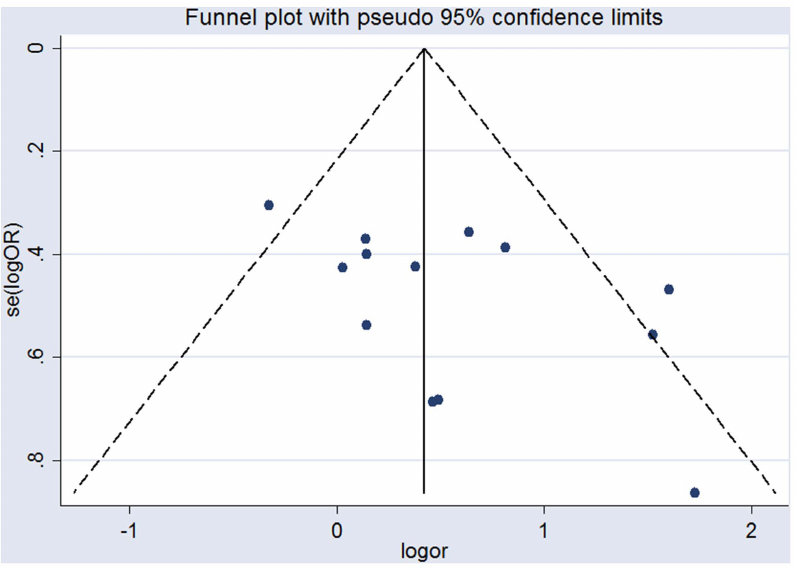
Figure 3. Funnel plot of all studies evaluating the association between DM and NAION. DM= diabetes mellitus; NAION= nonarteritic anterior ischemic optic